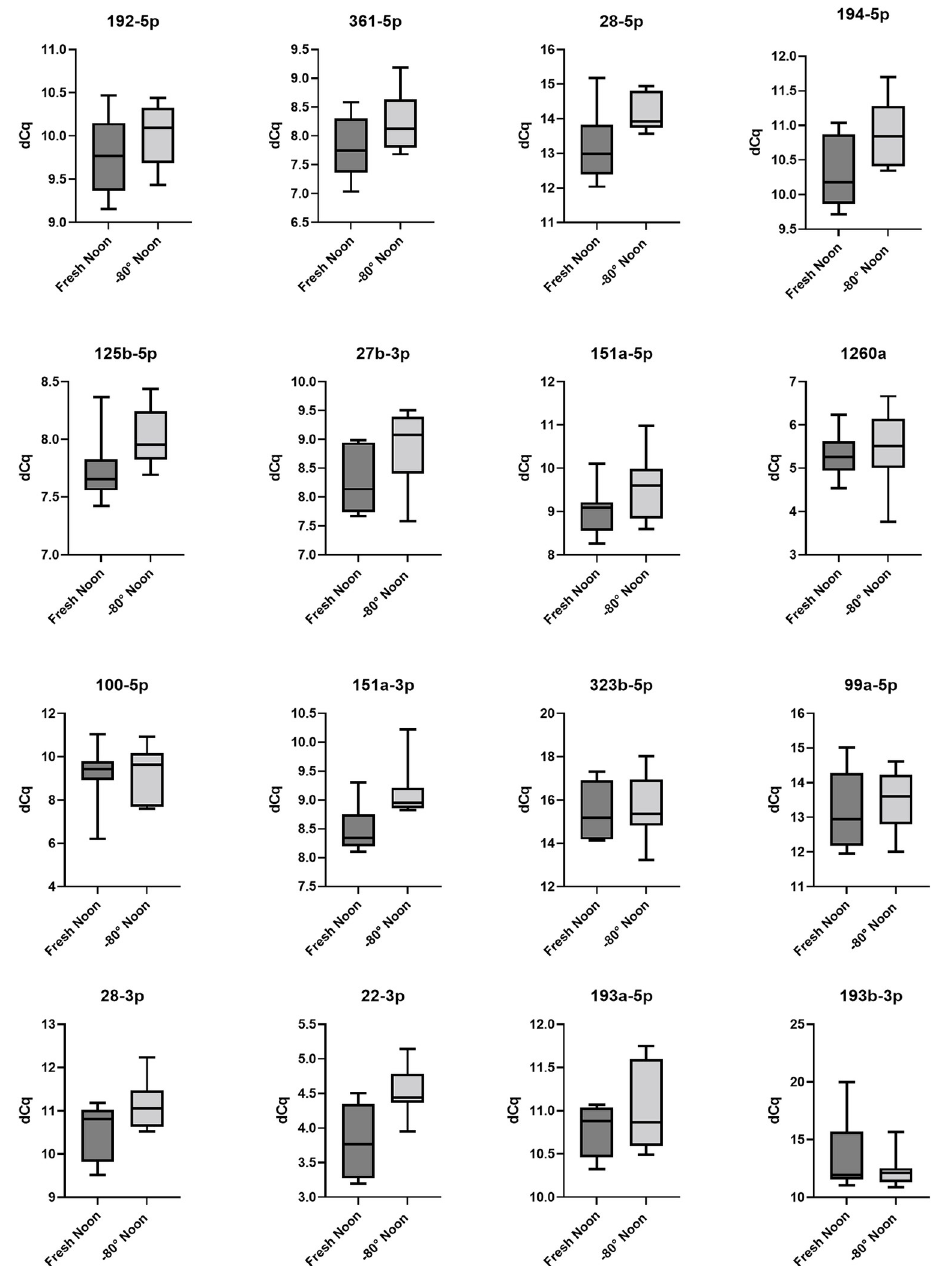
Fig 4. Fresh noon versus -80˚C noon. Box plots of dCq values of serum MiRNA samples taken in the afternoon compares the analysis of samples (n = 8) within 24 hours and the analysis of samples (n = 8) after 14 days at -80˚C. The expression of MiRNAs 28-5p, 194-5p, 151a-3p, 22-3p was lower after being stored at -80˚ for 14 days. The expression of miRNA 22-3p was significantly lower (p < 0,01).